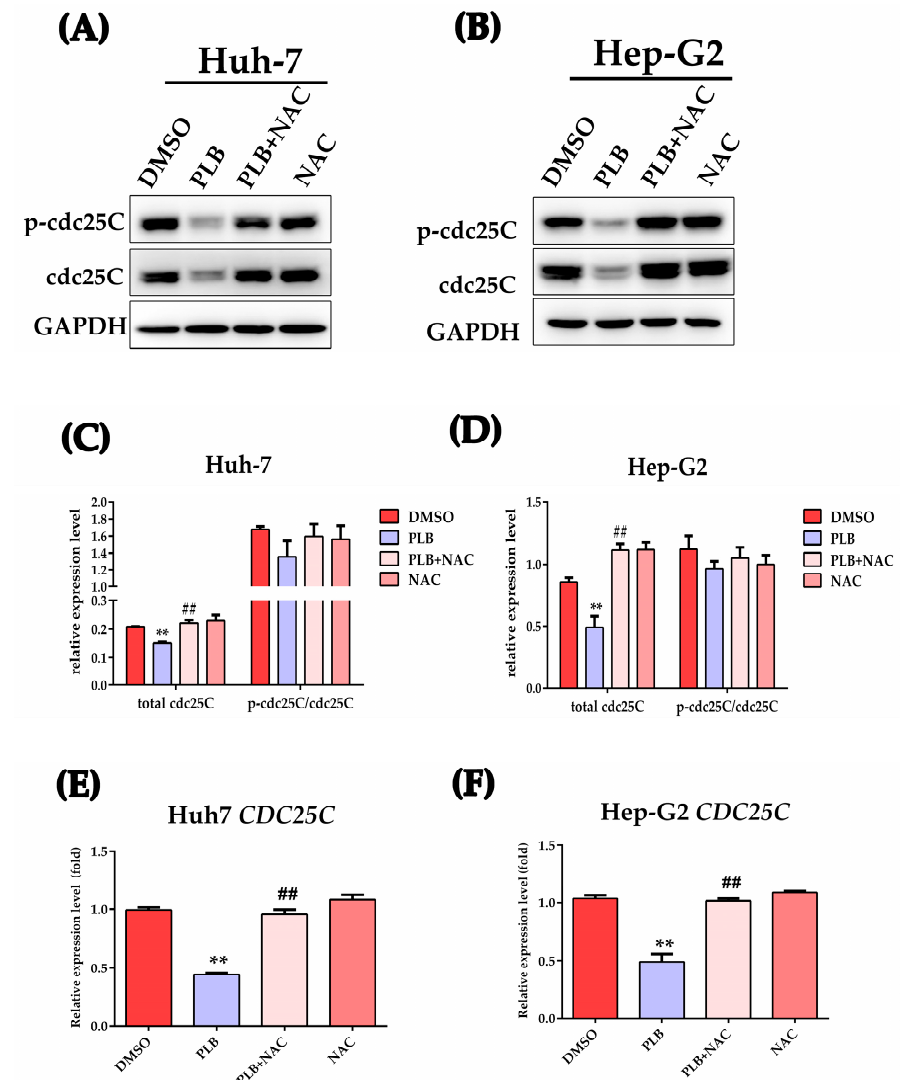
Figure 9. Plumbagin-induced ROS-dependent cdc25C downregulation. ( A , B ) HCC cells were pretreated with NAC (10 mM) or not for 1 h, and 10 µ M of PLB was added into the medium for 12 h. The expression of cdc25C and p-cdc25C (Ser216) was determined by Western blot analysis. ( C , D ) Gray value statistical analysis of the indicated proteins. ( E , F ) Cells were treated as mentioned above and the relative mRNA levels of gene CDC25C were determined by the RT-qPCR method. ** p < 0.01 vs. compared to the DMSO group, ## p < 0.01 compared to the PLB group; three independent experiments were performed.